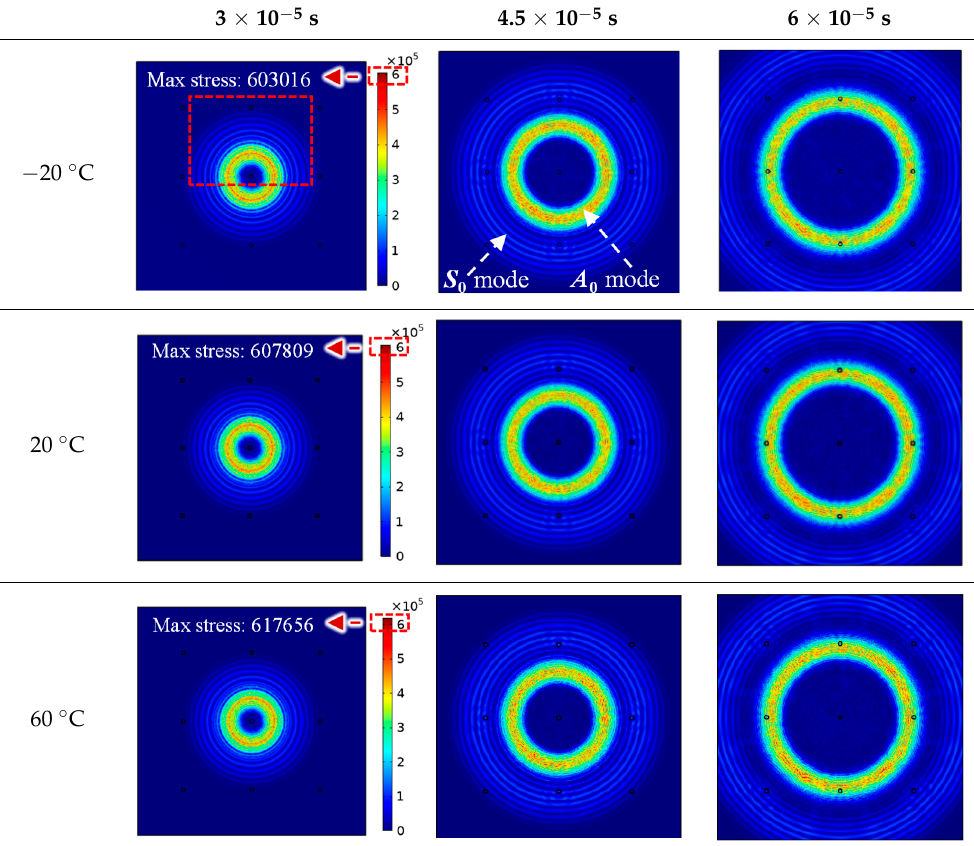
Table 4. Typical wave fields of LW propagation with the PZTs under temperature effect.